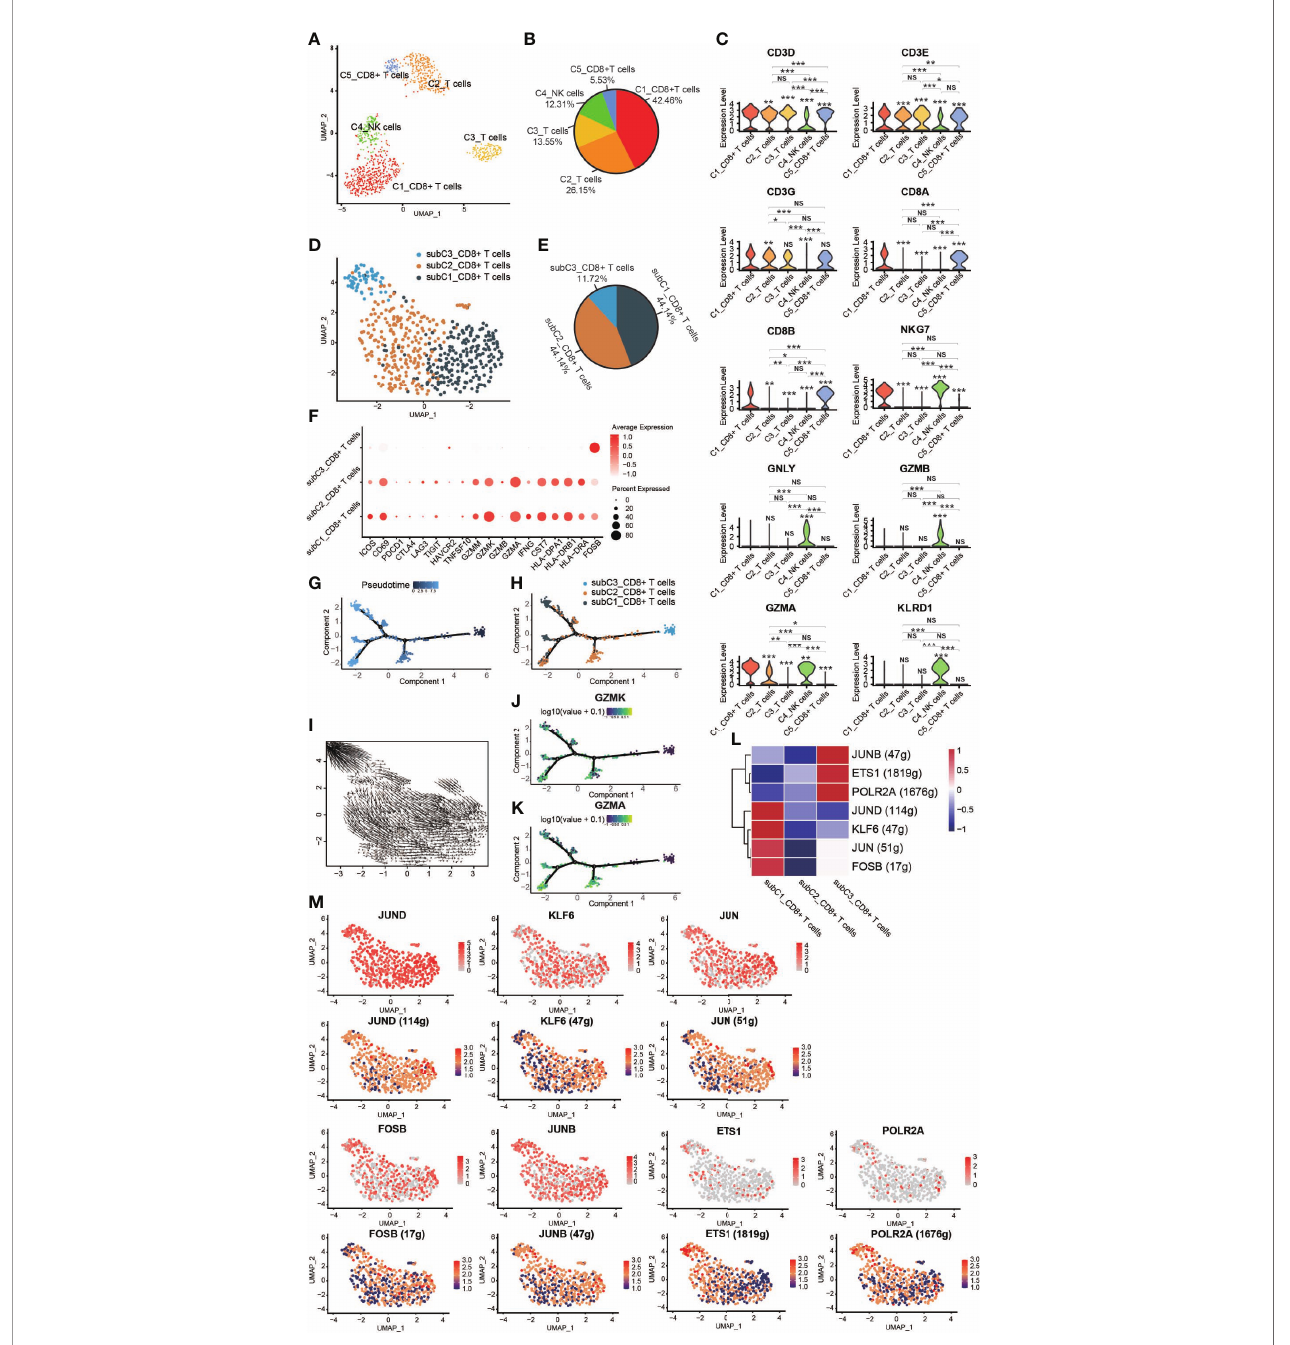
FIGURE 5 | Heterogeneity of NK/T cells in GCTB. (A) UMAP plot showing different subtypes of NK/T cells. (B) A pie chart depicting the subtypes composition of NK/T cells. (C) Violin plots displaying the expression of representative, well-known markers across the NK/T cells types identi fi ed in GCTB (*P <0.05, **P <0.01, ***P <0.001, NS: No statistical signi fi cance). (D) UMAP plot showing different subtypes of CD8 + T cells. (E) A pie chart indicating the subtypes composition of CD8 + T cells. (F) Dot-plot of marker genes in subtypes of CD8 + T cells. Shades of red represent the expression level, and the dot sizes represent the relative abundance of each gene. (G, H) The dynamics of CD8 + T cell subtype as shown by the monocle 2 trajectory plot. (I) An RNA velocity fi eld projected onto the UMAP plot of the subtype of CD8 + T cells. Arrows indicate the direction of the differentiation and its average velocity. (J, K) The expression levels of the marker genes GZMK and GZMA, which are related to the differentiation of a subtype of CD8 + T cells. (L) Heatmap of the AUC scores of expression regulation by transcription factors as estimated by SCENIC. (M) UMAP plot of CD8 + T cell subtype, the expression level (up) and for the AUC of the estimated regulon activity of these transcription factors (down). GCTB, giant cell tumor of bone; UMAP, uniform manifold approximation and projection for dimension reduction; NK cells, natural killer cells; GZMK, Granzyme K; GZMA, Granzyme